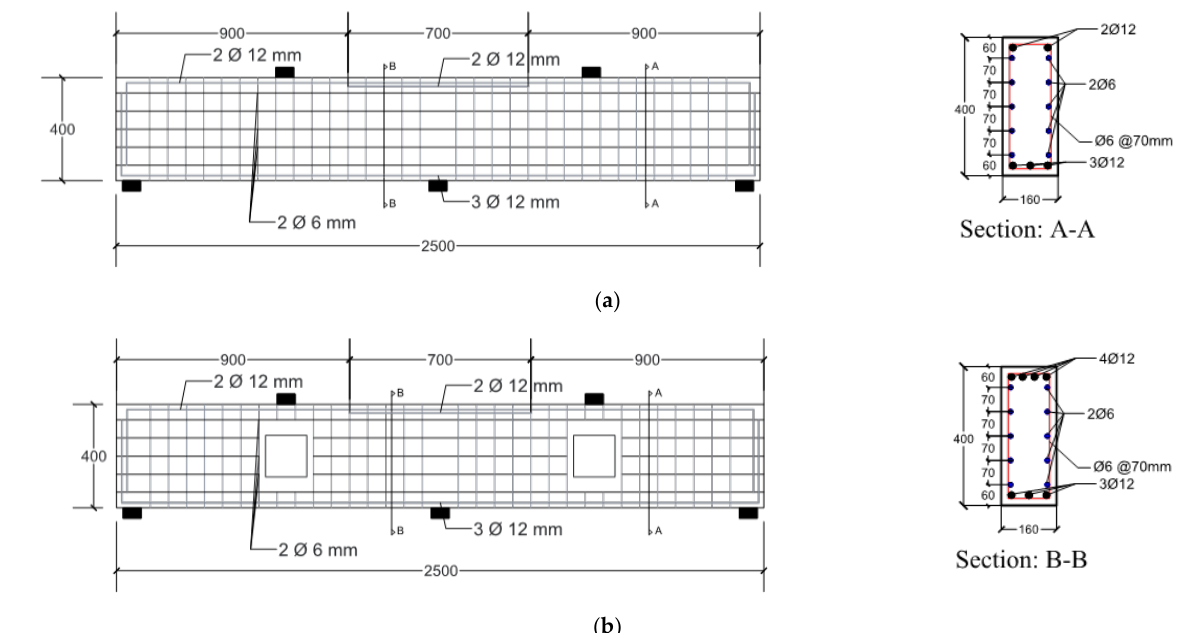
Figure 3. Details of steel reinforcement for the tested specimens: ( a ) specimen CDB – Solid; ( b ) specimens CDB – O – U and CDB – O – S (all dimensions are in mm).